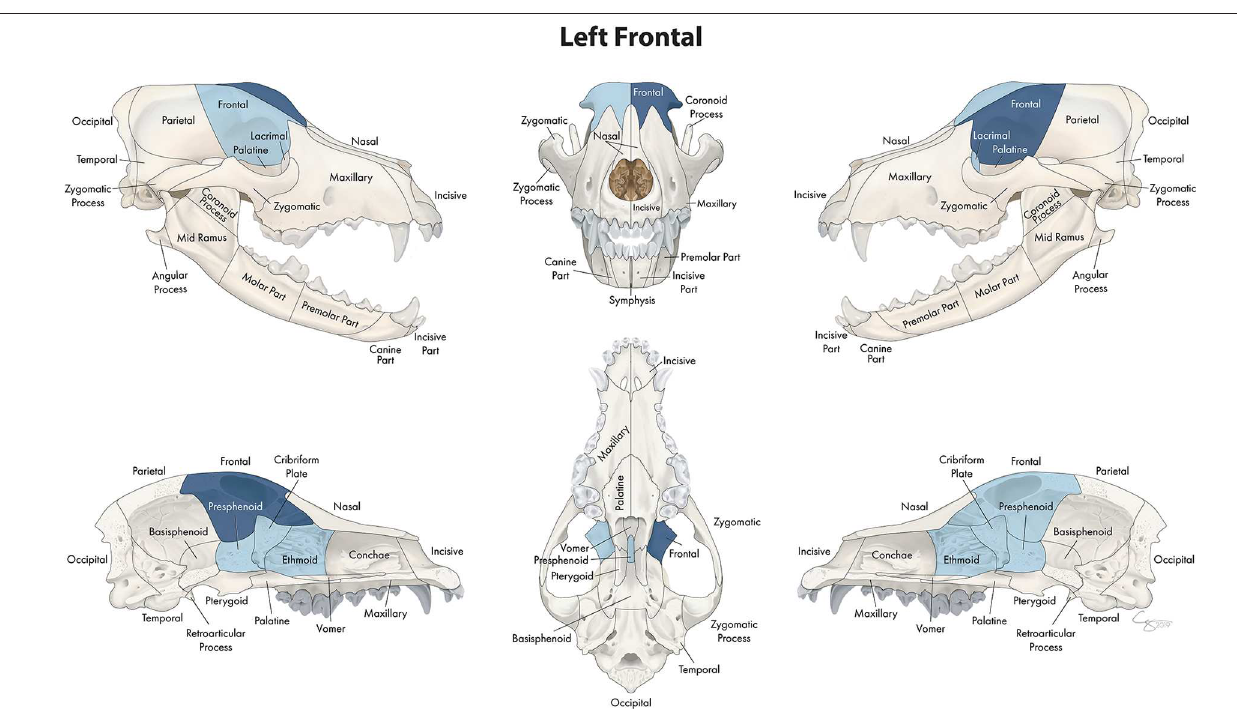
FIGURE 11 | Significant bones or regions fractured concurrently with the frontal bone. When the frontal bone was the region of interest, the cribriform plate, ethmoid bone, presphenoid bone, ipsilateral lacrimal bone, and contralateral frontal bone fractured concurrently. Although the left frontal bone is shown, when the right frontal bone was the region of interest, a mirror image of concurrently fractured locations